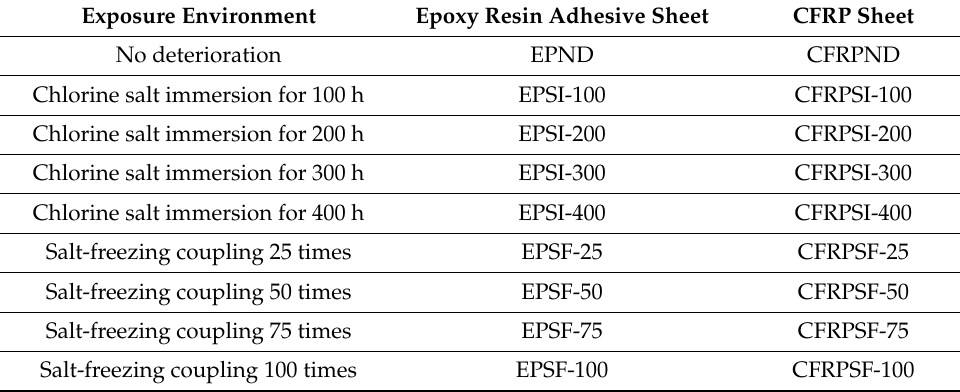
Table 4. Number of concrete specimens.